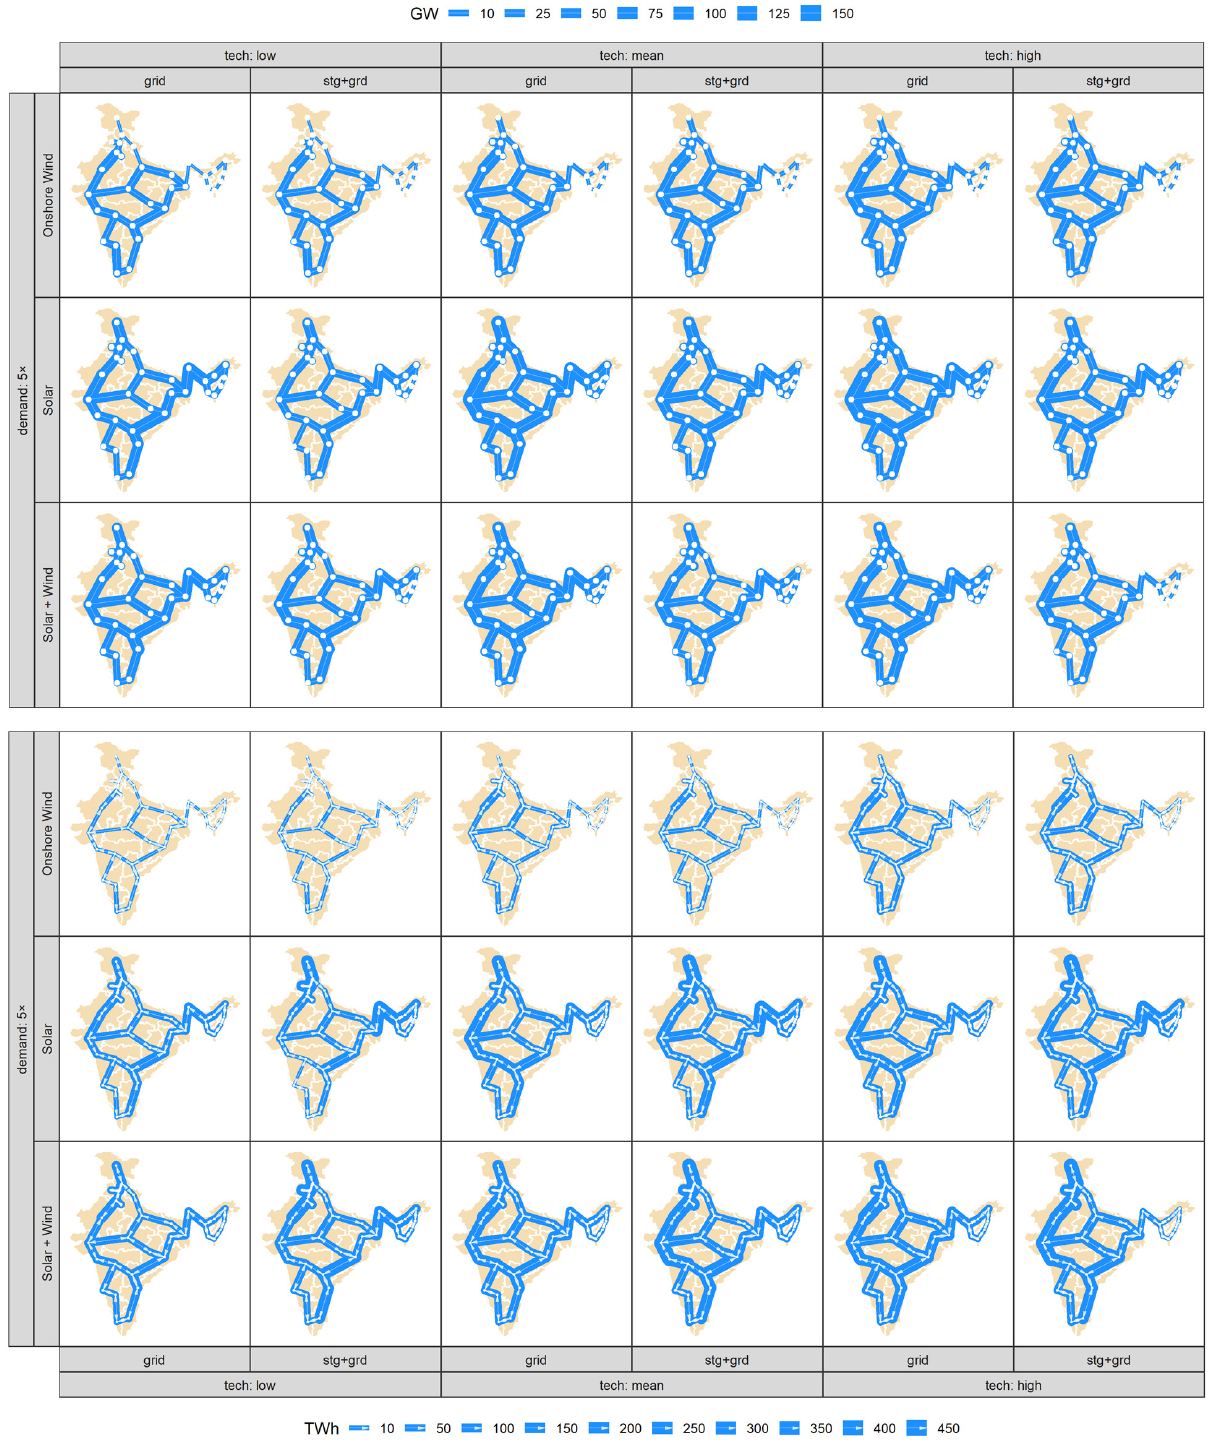
Figure A28. Interregional grid capacity and annual trades by scenario, demand level fivefold that of 2019.